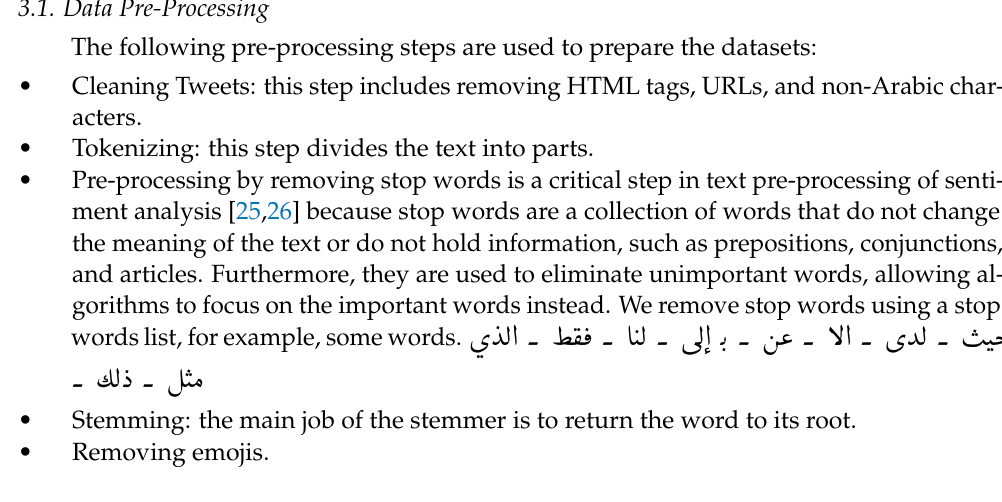
Figure 1. The main phases of prediction Arabic sentiment